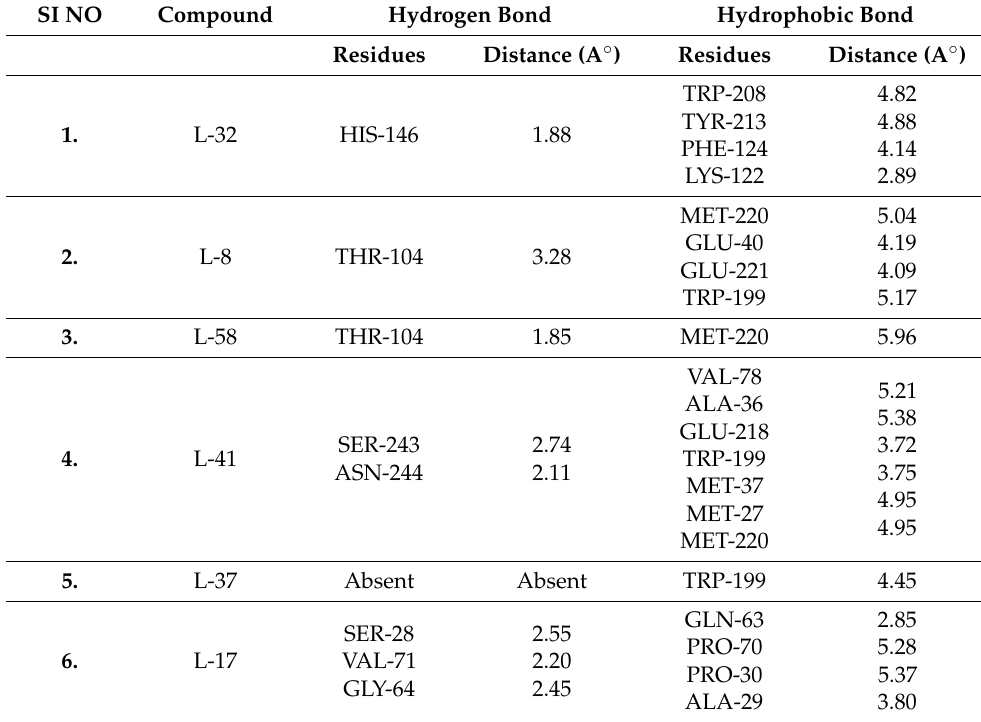
Table 4. Protein–ligand interactions of nucleosidase (MTAN) enzymes (PDB ID: 5b7n) with the top 8 volatile compounds of Klebsiella Pneumoniae